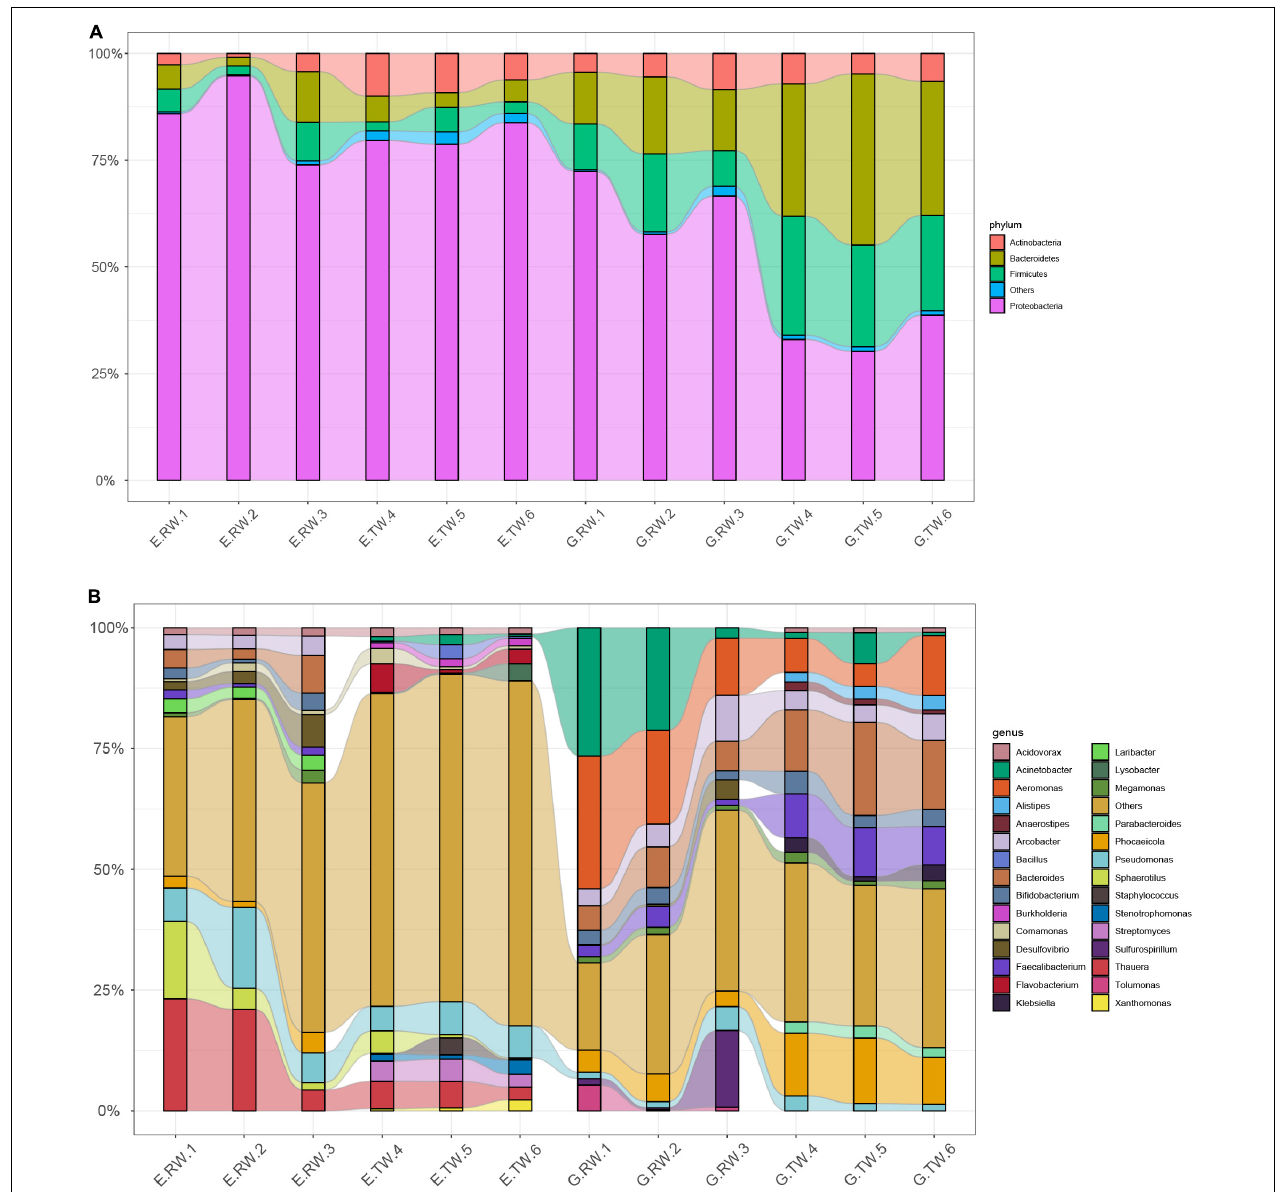
FIGURE 3 | The relative abundance of bacteria (A) at the phylum level and (B) the genus level, less abundant ( < 1%) and unclassified taxa are grouped together as